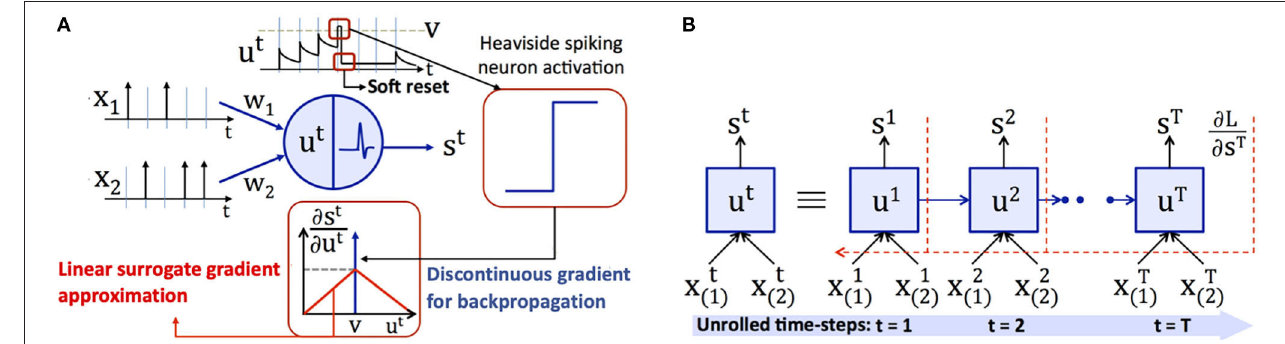
FIGURE 2 | (A) Spike-based input representation, and membrane potential dynamics, soft reset behavior, and piece-wise linear surrogate gradient for a leaky integrate and fire (LIF) neuron. An LIF neuron integrates the weighted sum of input spikes ( X t ( i ) ) with the synaptic weights ( w i ) and emits a spike ( s t ) when its membrane potential ( u t ) exceeds the firing threshold ( v ). In the event of a spike, the membrane potential is reduced (or soft reset) by an amount equal to the firing threshold. During backpropagation, the discontinuous Dirac delta gradient ( ∂ s t ) is replaced by a continuous surrogate gradient approximation. (B) Illustration of backpropagation ∂ u t ) is accumulated over T simulation through time for a spiking neuron, where in the output loss ( ∂ L ∂ s t